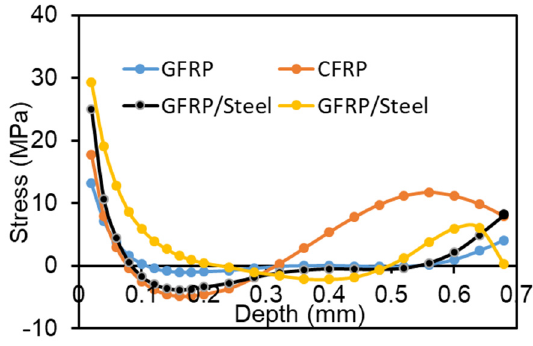
Figure 21. Residual stresses σ x experimentally determined by the HDM for GFRP, CFRP, GFRP/steel and CFRP/steel composites. See text for details.